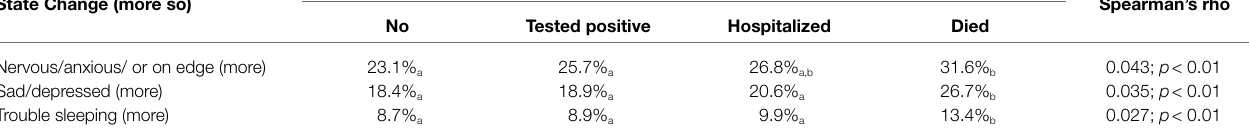
Nervous/anxious/ or on edge